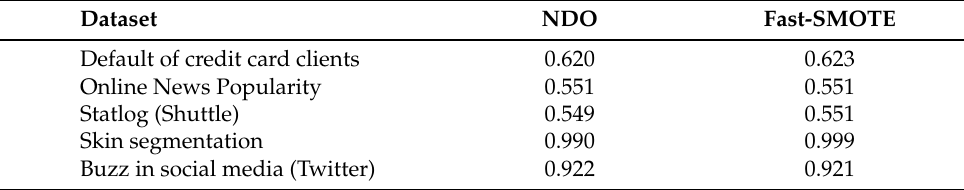
Table 6. AUC results of Cart classifier for one of the 5 datasets from the UCI repository. Dataset NDO Fast-SMOTE Default of credit card clients 0.620